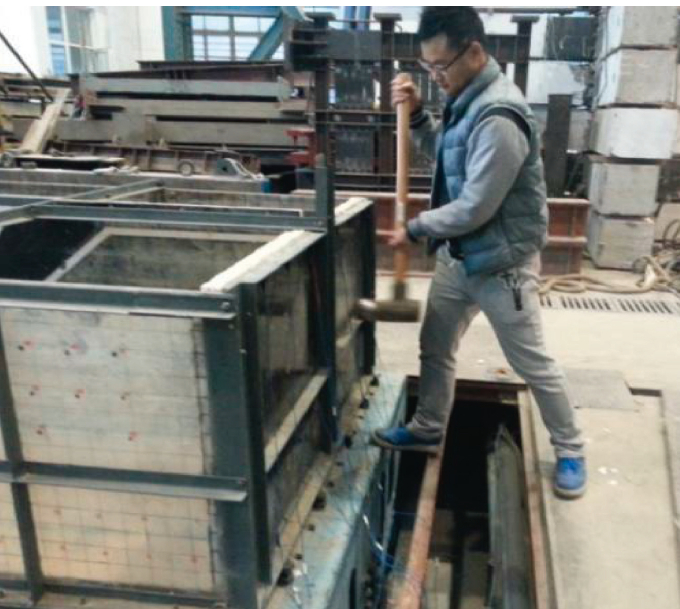
Figure 7: Hammer test of model box.